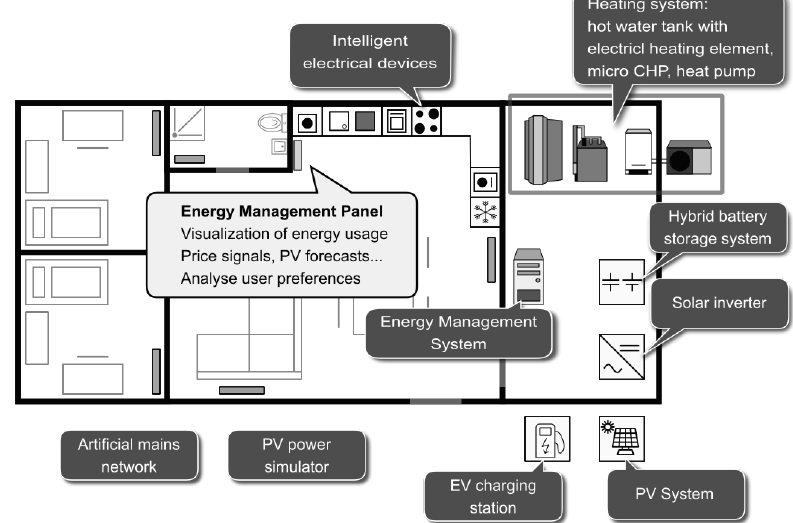
Figure 1. Schematic overview of the Energy Smart Home Lab.